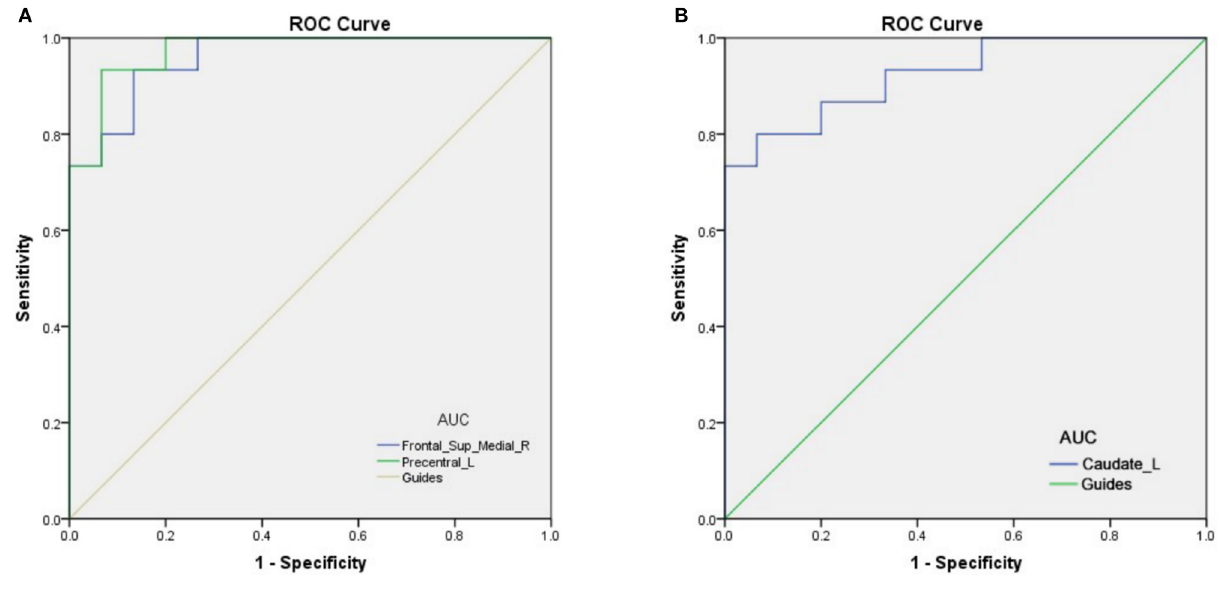
FIGURE 3 | The ROC curve analysis of the mean PerAF values of different brain regions. (A) The AUCs for Frontal_Sup_Medial_R and Precentral_L were 0.960 ( p < 0.0001; 95% CI: 0.900–1.000) and 0.973 ( p < 0.0001; 95% CI: 0.926–1.000), respectively (B) The AUC was 0.924 ( p < 0.0001; 95% CI: 0.831–1.000)